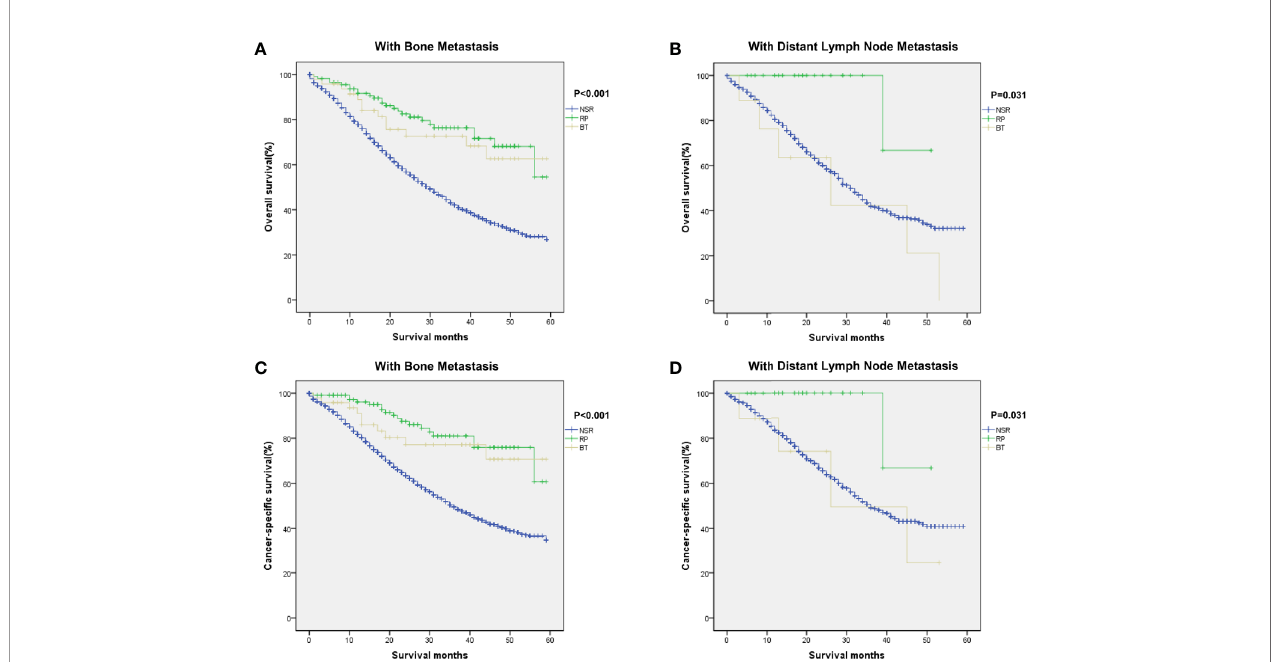
FIGURE 3 | Kaplan – Meier curves of overall and cancer-speci fi c survival in the NSR, RP, and BT groups were performed in patients with bone metastases (A, C) and distant lymph nodes metastases (B, D) .